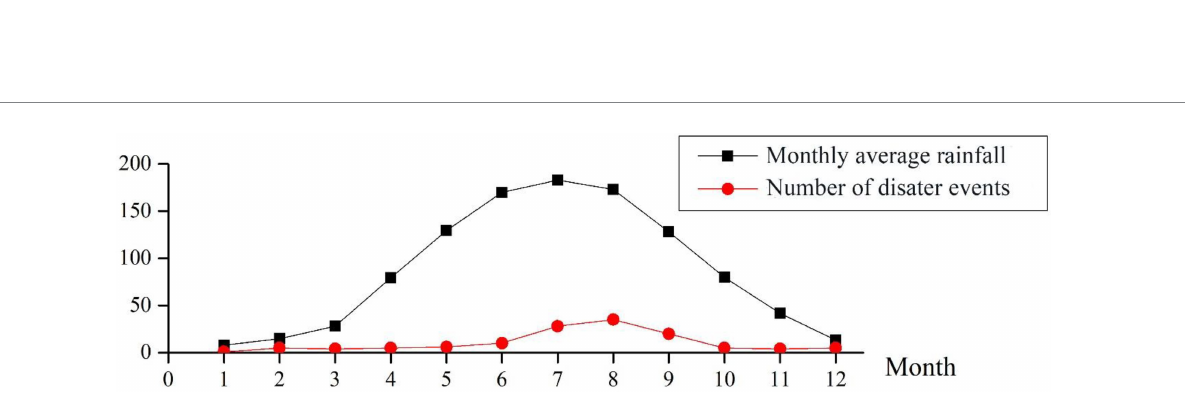
FIGURE 12 Correlation diagram between the average rainfall and the number of geological disasters in Ganluo